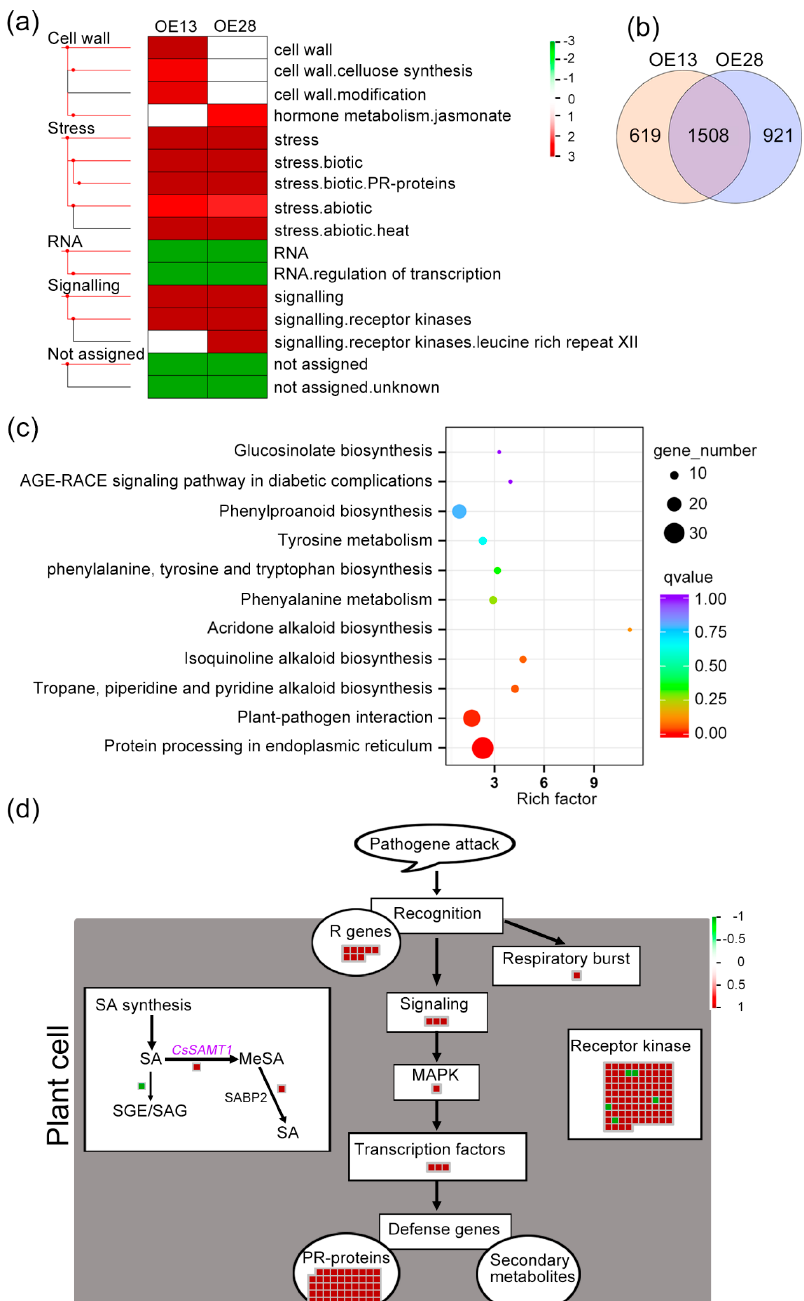
Figure 6. The global transcription profiles affected by CsSAMT1 overexpression in the OE13 and OE28 lines. ( a ) PageMan comparison of differentially represented pathways and functional categories between the differentially expressed genes (DEGs) in the OE13 and OE28 lines. Rectangular blocks denote the MapMan pathway or functional categories. Up- and downregulated categories are shown in red and green, respectively. The categories differentially represented in the transgenic plants are indicated on the right. ( b ) Venn analysis of DEGs from the OE13 and OE28 lines. 1508 DEGs were shared by the two lines. ( c ) KEGG enrichment of the 1508 DEGs shared by the OE13 and OE28 lines indicating the 11 representative KEGG pathways. ( d ) MapMan visualization of DEGs involved in the defense response of transgenic citrus plants. The 1508 DEGs were visualized using the MapMan tool. Every square block indicates a DEG and significantly up- and downregulated DEGs are displayed in red and green, respectively. SA, salicylic acid; MeSA, methyl salicylate; SABP2, salicylic acid-binding protein 2; SGE, SA glucose ester; SAG, SA glucoside. The scale bar represents log2 fold change